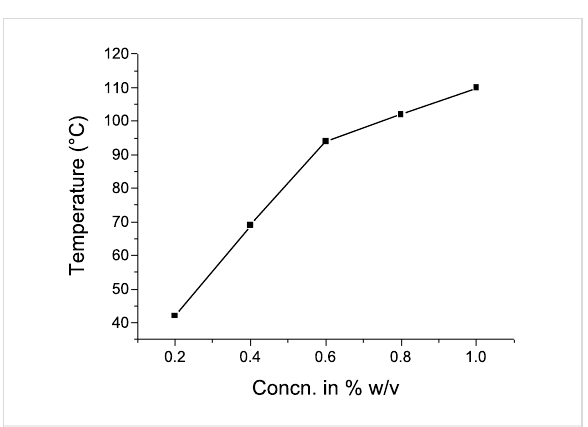
Figure 6: Gel melting profile of diethylaminolithocholyl iodide 1 gel in 1,2-dichlorobenzene.